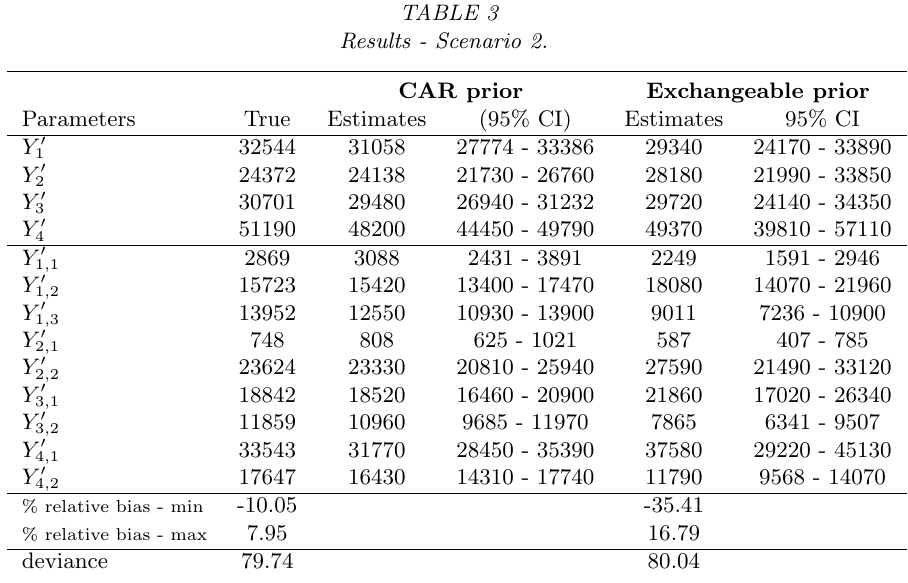
Results - Scenario